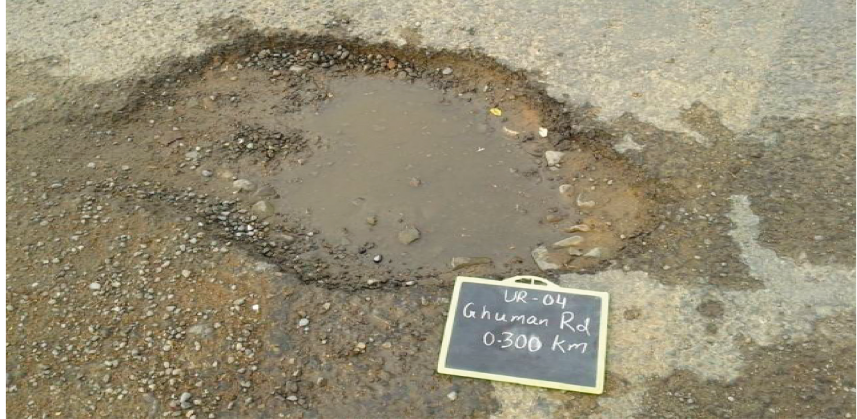
Figure 6: Pothole at chainage 0.300km on the section